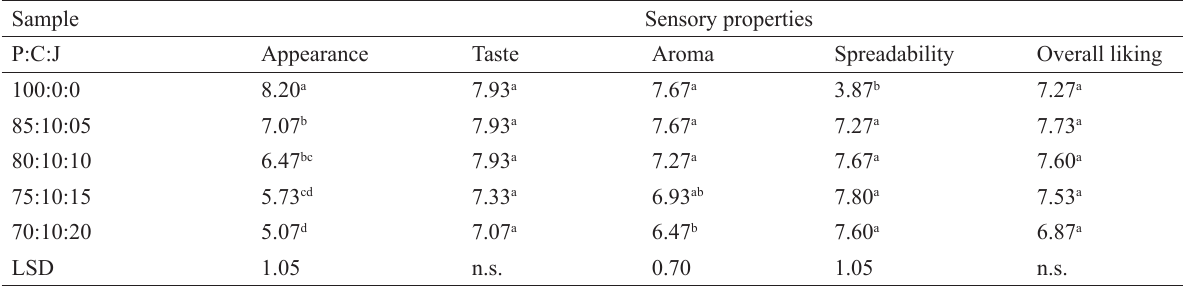
Table 5 Sensory attributes of pineapple jam with cucumber and Jatropha leaf in different proportions Sample Sensory properties Aroma Spreadability Overall